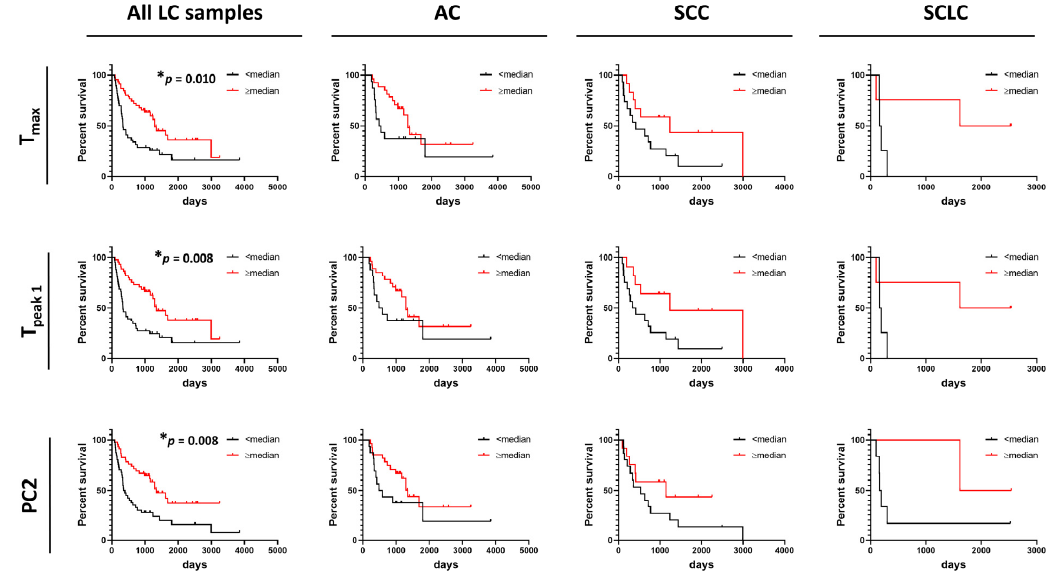
Figure 6. Association between progression-free survival of lung cancer patients and summary metrics or PCs. Analysis of survival functions for progression free survival of lung cancer patients dichotomized by median values of selected summary metrics/PCs, using the Mantel–Cox test. Graphs in the first column represent data for all combined lung cancer patients ( n = 85), columns two to four represent patients dichotomized by LC subtypes: AC LC ( n = 43), SCC LC ( n = 27), and SCLC ( n = 8), respectively. *, adjusted p -value < 0.05